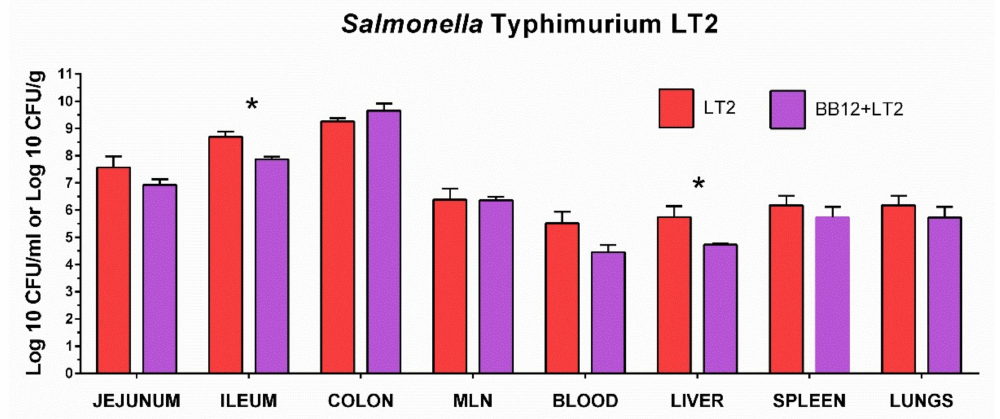
Figure 3. Colony-forming units (CFU) of S . Typhimurium LT2 in the gnotobiotic piglets. S . Typhimurium LT2 CFU was counted in the jejunum, ileum, colon, and blood (all CFU/mL) and mesenteric lymph nodes (MLN), liver, spleen, and lungs (all CFU/g) in the piglets infected with S . Typhimurium LT2 for 24 h (LT2; red column) and the piglets monoassociated with B. animalis subsp. lactis and one week later infected with S . Typhimurium LT2 for 24 h (BB12 + LT2; violet column). Interferences between B. animalis subsp. lactis BB-12 and S . Typhimurium were evaluated by unpaired t -test. Statistical differences were marked with asterisks at p < 0.05. Log CFU are depicted as mean + SEM and n = 6 piglets for all